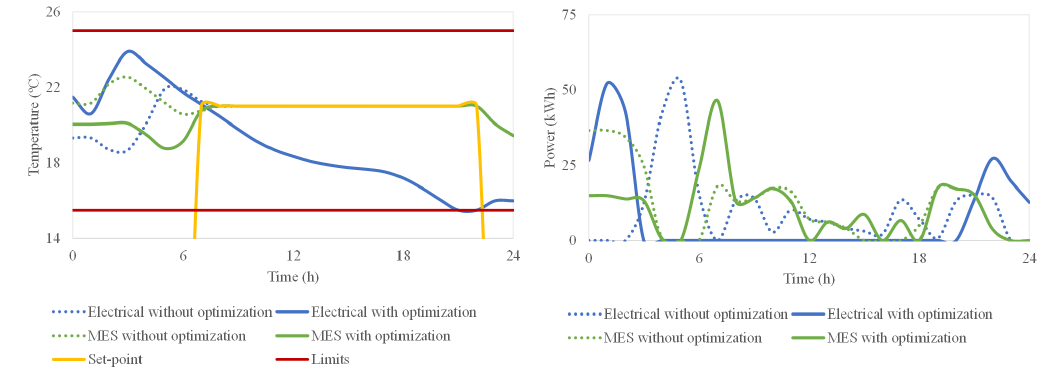
Figure 15. Temperature and power consumed for heating in the main room of the